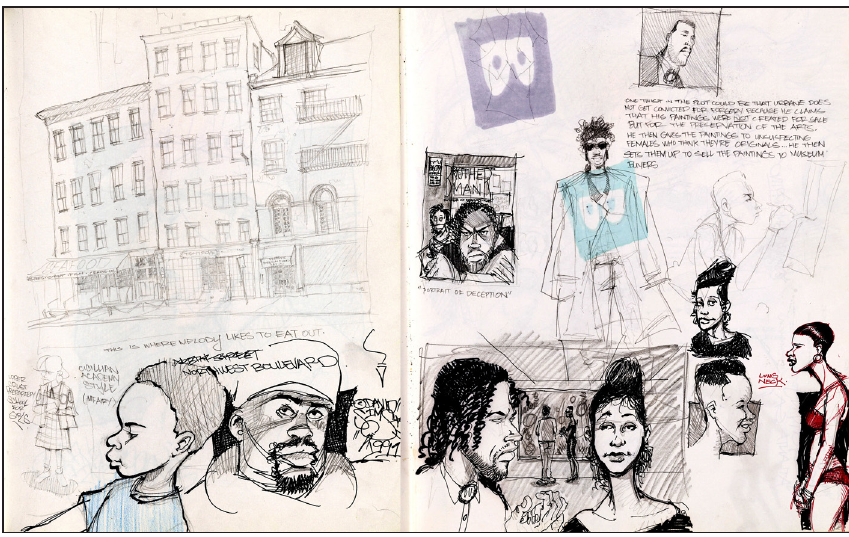
Figure 2: Excerpt from Dawud Anyabwile Sketchbook © Big City Entertainment,